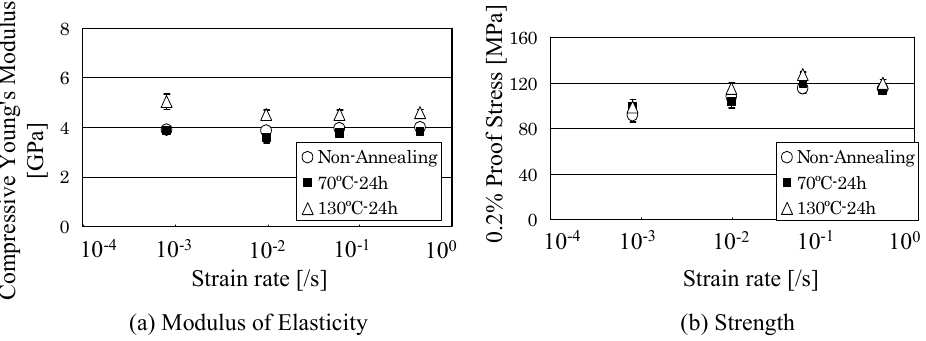
Figure 8 The results of compressive tests of PLLA specimens with strain